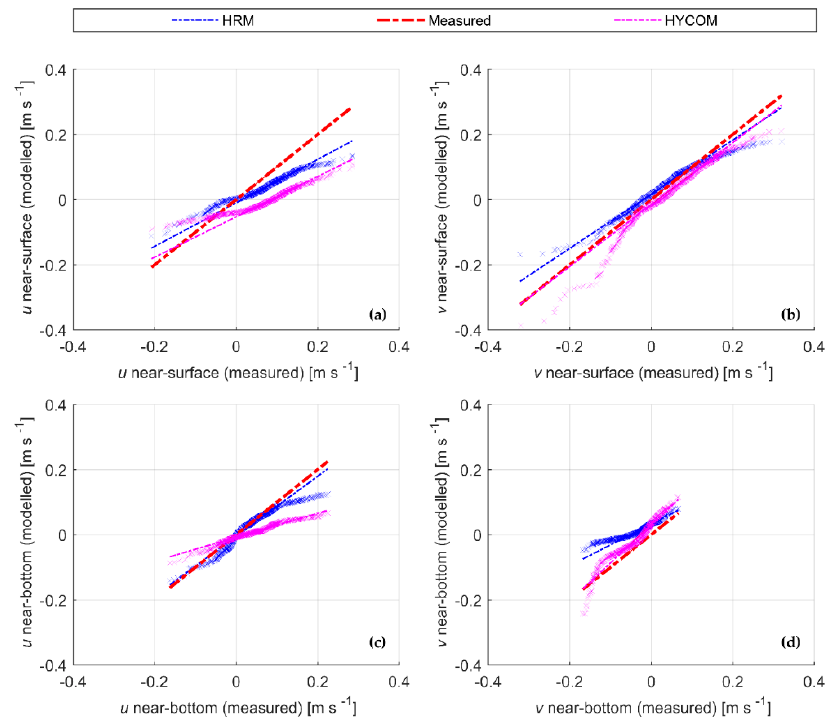
Figure 2. Quantile-quantile plot of near surface ( a , b ) and near bottom ( c , d ) u ( a , c ) and v ( b , d ) velocity components at CU1, north-west of Green Point.